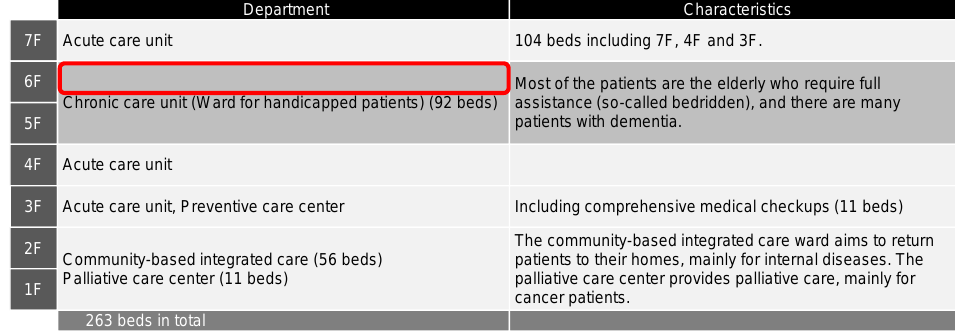
Figure 5. Floor map of Hospital B with characteristics. The shaded part indicates the ward with a chronic care unit. The bold line on the sixth floor indicates the ward with the index case.